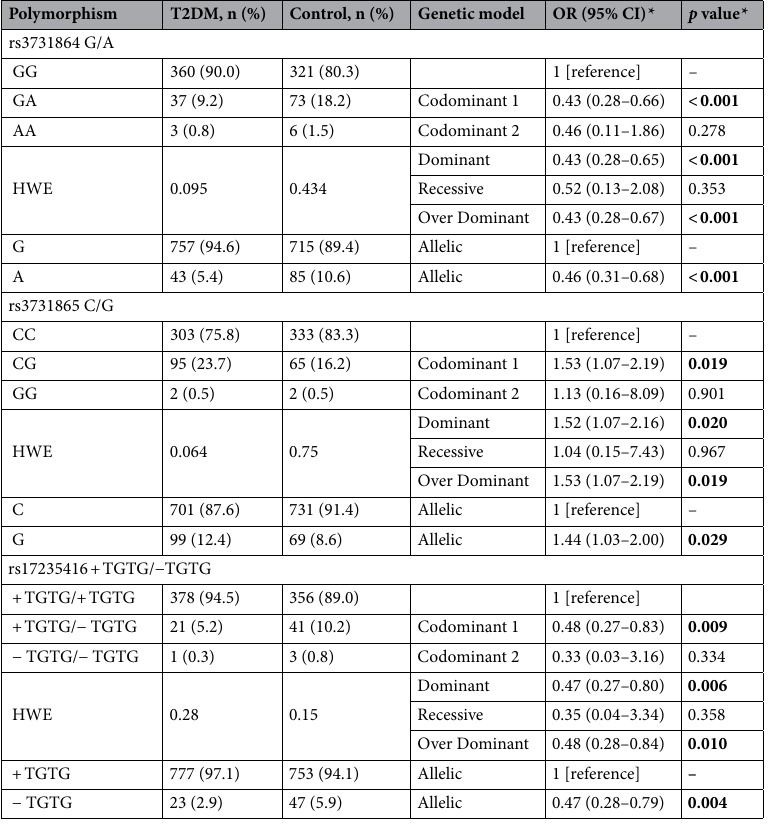
Table 2. Allelic and genotypic distribution of SLC11A1 gene polymorphisms. T2DM Type 2 Diabetes Mellitus, n represents the numbers, CI confidence intervals, OR odds ratio, HWE Hardy–Weinberg equilibrium, BMI body mass index, * p -value and OR (95% CI), BMI-adjusted. Codominant 1 and Codominant 2 represent the heterozygous and homozygous codominant models, respectively. p < 0.05 were considered statistically significant, indicated in